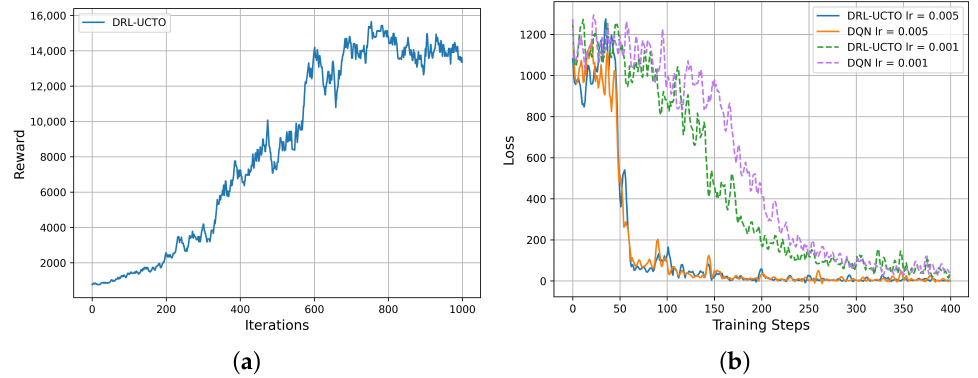
Figure 3. Convergence verification of the algorithm. ( a ) Reward value versus number of iterations for the DRL-UCTO algorithm. ( b ) Loss versus training steps for different algorithms.